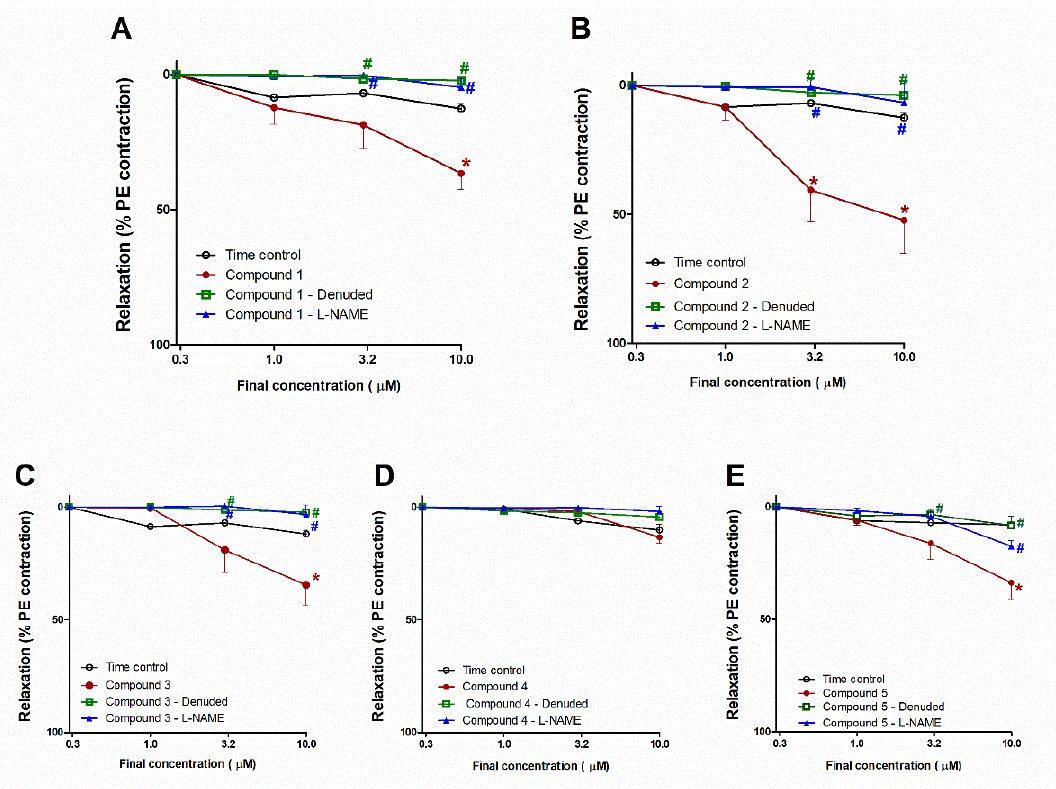
Figure 5. Influence of compounds 1 – 5 on PE–precontracted separated intact or denuded aorta or aorta preincubated with a nitric oxide synthase inhibitor (L-NAME) compared with time control ( A – E ). Results are introduced as mean ± SEM ( n = 8). * Significantly varies from the corresponding time control values ( p < 0.05). # Significantly varies from the corresponding values of compound 1 ( p < 0.05) by two-way ANOVA and Newmans–Keuls posthoc test.